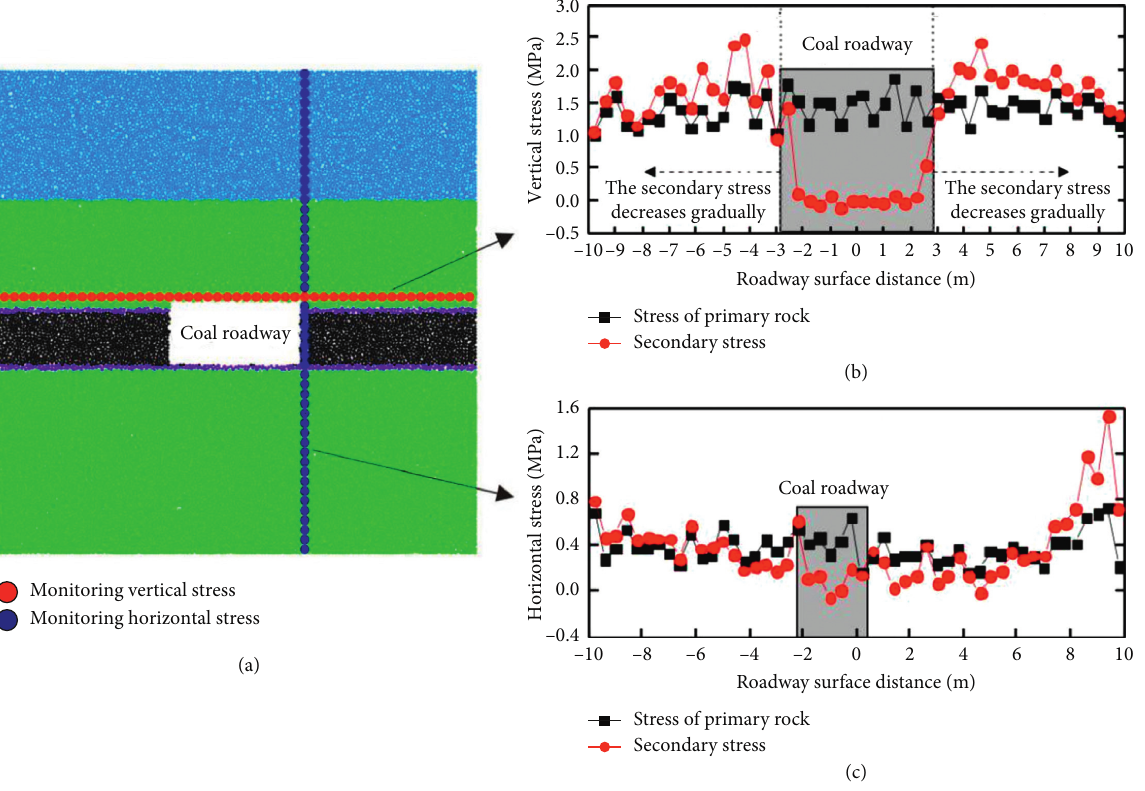
Figure 9: Monitoring of the roadway-surrounding